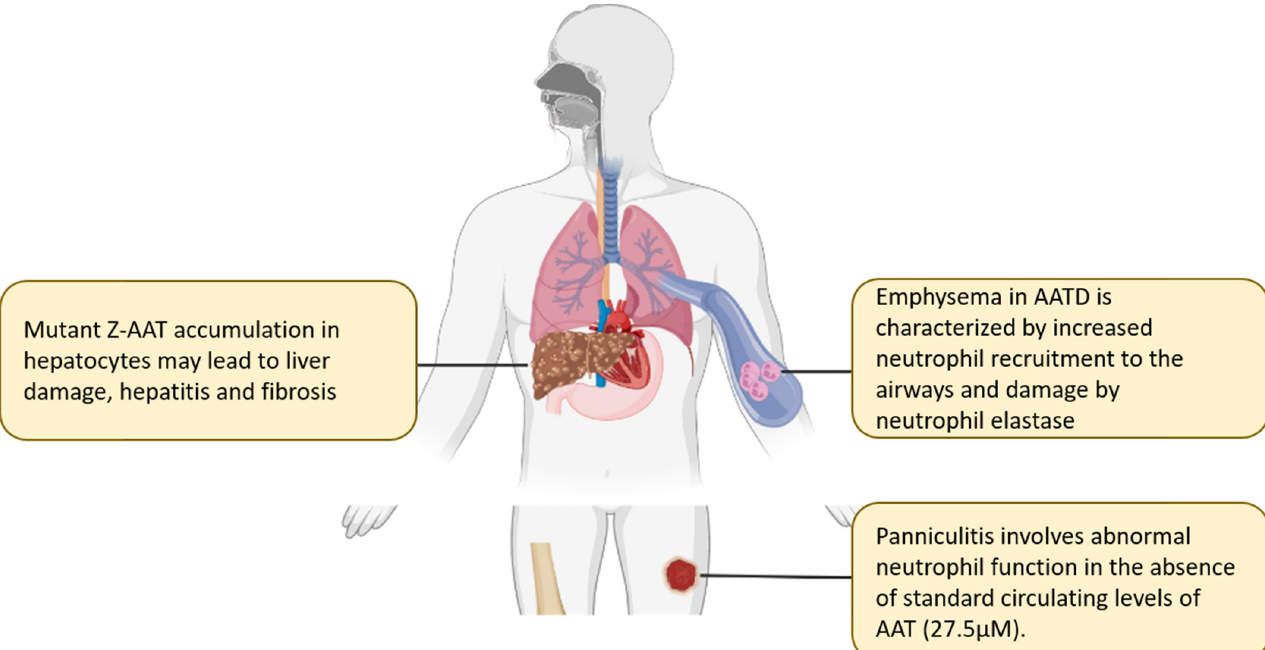
Figure 3. Clinical implications of alpha-1 antitrypsin deficiency. Polymerised aggregates of Z-AAT protein are implicated in the pathogenesis of liver cirrhosis and chronic hepatitis. Accumulation of Z-AAT in hepatocytes leads to impaired secretion of the protein, with individuals homozygous for the Z mutation having 10–15% of normal circulating levels of AAT. Deficiency in AAT results in high influx of neutrophils to the airways, where increased release of serine proteases and uninhibited NE activity can cause damage to lung parenchyma, ultimately leading to emphysema and COPD. In rare cases, AATD is associated with a severe skin condition known as panniculitis and antineutrophil cytoplasmic antibody associated vasculitis (granulomatosis with polyangitis, formally Wegener’s granulomatosis). Panniculitis is characterised by intense neutrophil infiltrates in the subcutaneous tissues and resultant tissue destruction due to the low levels of antiprotease and high levels of protease.